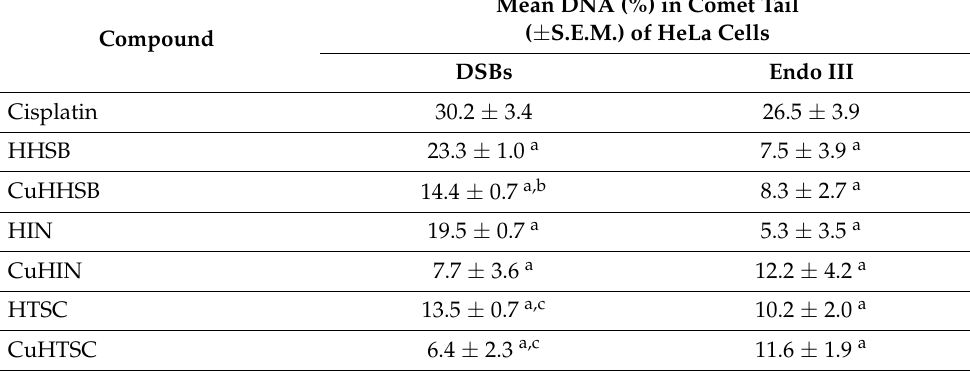
Table 3. DNA damage ± standard error of the mean (S.E.M.) in HeLa cells after exposition to tested compounds, (50 µ M) expressed as percentage of DNA in the tail of comets recognised by Endo III enzyme (oxidative DNA damage) and in the neutral (double-strand breaks) comet assay. The number of cells analysed in each treatment was from 50 to 100. Results significantly different from a cisplatin; b,c Cu ligand, ANOVA ( p ≤